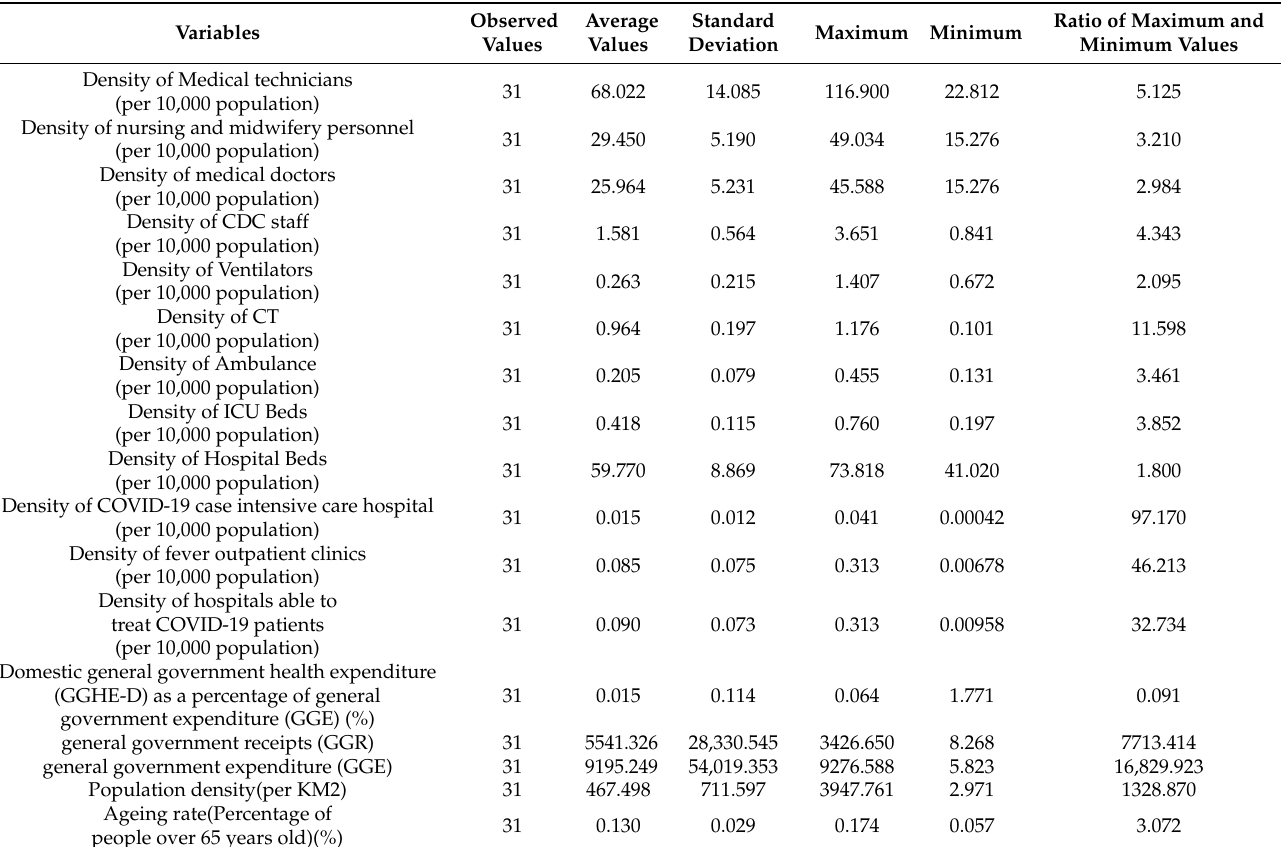
Table 4. Descriptive statistics of HRCC indicators for 31 provinces in mainland China.